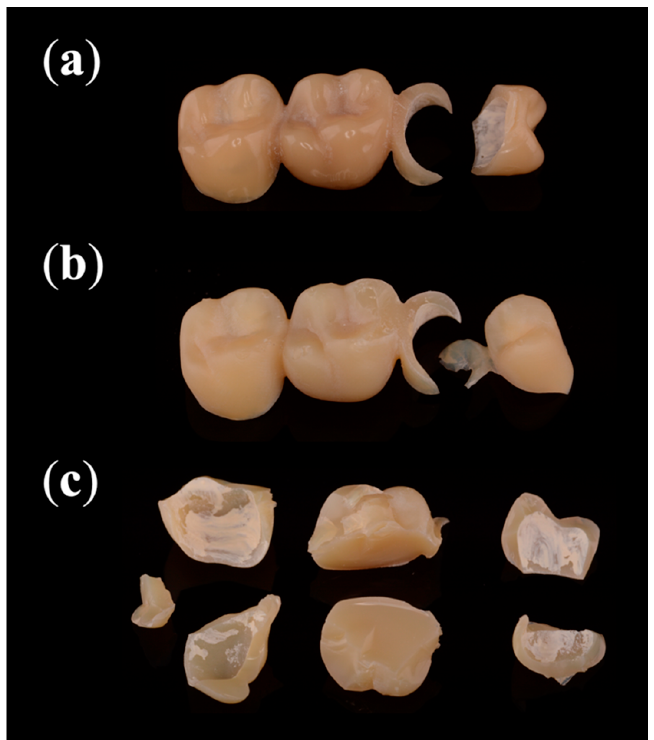
Figure 8. Most common fracture patterns: ( a ) statically loaded subtractive manufactured FDPs and ( b ) dynamically loaded additive manufactured FDPs fractured into two pieces, while ( c ) statically loaded additive manufactured FDPs fractured into multiple pieces. Table 2. Areas of failures during dynamic and static loading of FDPs.